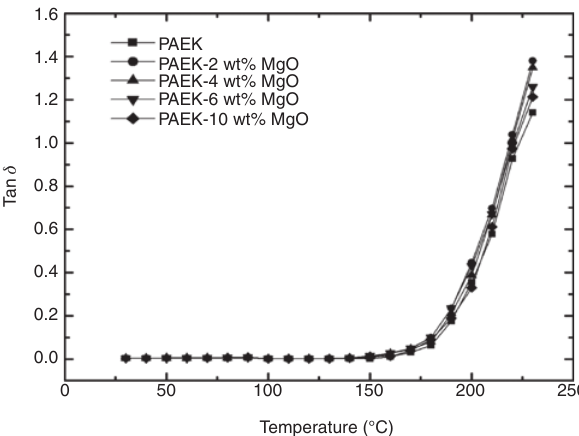
Figure 6: Effect of temperature on tan δ for PAEK-MgO